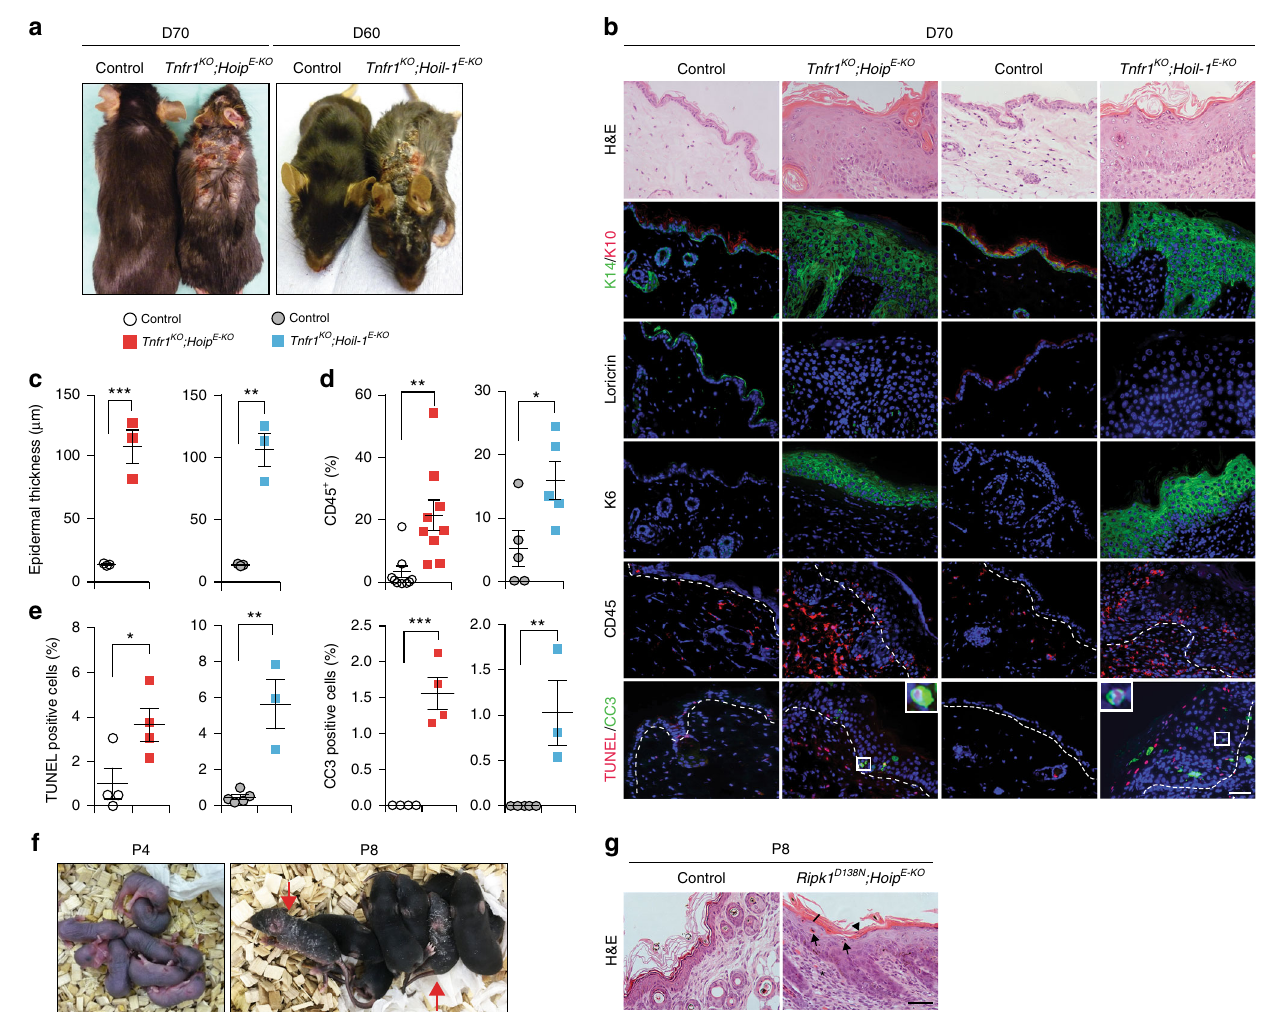
Fig. 2 Dermatitis of Hoip E-KO and Hoil-1 E-KO mice is delayed by TNFR1 de fi ciency but not by abrogation of the kinase activity of RIPK1. a , f Representative images of mice of the indicated genotypes, ( n = 10 mice per genotype). Arrows in f indicate Ripk1 D138N ;Hoip E-KO mice at P8 (right panel). Ripk1 D138N ; Hoip E-KO mice were indistinguishable from control littermates at P4 (left panel) ( f ). b Representative images of skin sections stained with H&E, the indicated antibodies or TUNEL from mice of the indicated genotypes ( n = 3 mice per genotype). Nuclei were stained with DAPI (blue). White dashed lines indicate boundary of epidermis (above) and dermis (below). Scale bar, 50 µ m. c Epidermal thickness quanti fi cation at D70. Data are presented as mean values ± s.e.m. ( n = 3 per genotype). ** P ≤ 0.01, *** P ≤ 0.001. d Percentages of CD45 + cells in the skin of the indicated genotypes at D70. Data